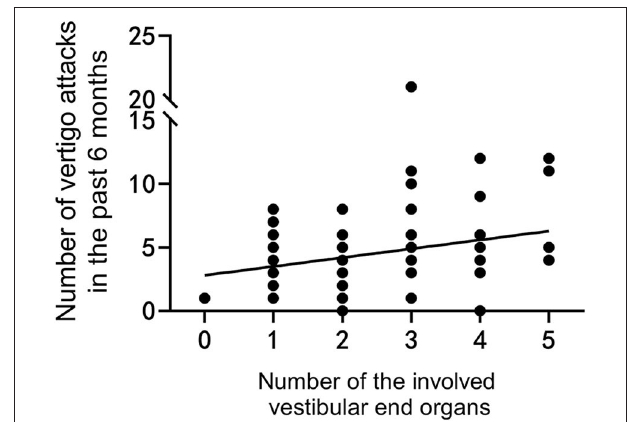
model in that the number of the involved vestibular end organs could predict severe DHI statistically significantly (odds ratio, 4.724; 95% CI, 1.597–13.974; P = 0.005); the model could predict